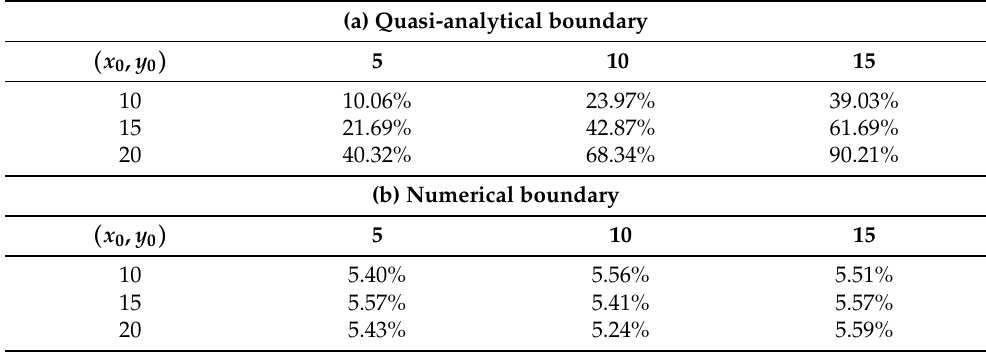
Table 2. Percentage of cases when a firm undertakes an investment within the next 5 years for